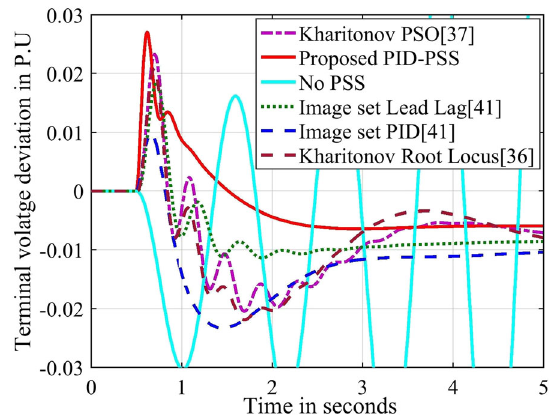
Fig. 13 Comparision of speed deviation response of the proposed with existing methods to 0.1 p.u. Torque disturbance at P = 0.2 p.u. and Q = -0.4